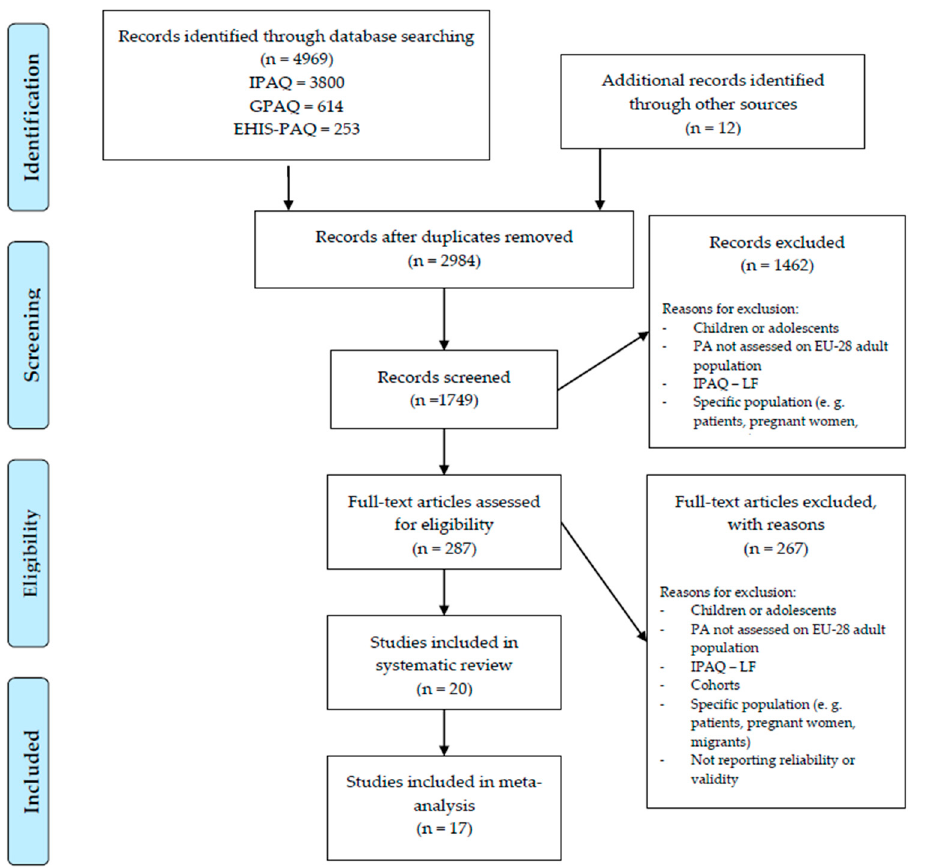
Figure 1. Flowchart showing the study identification process.